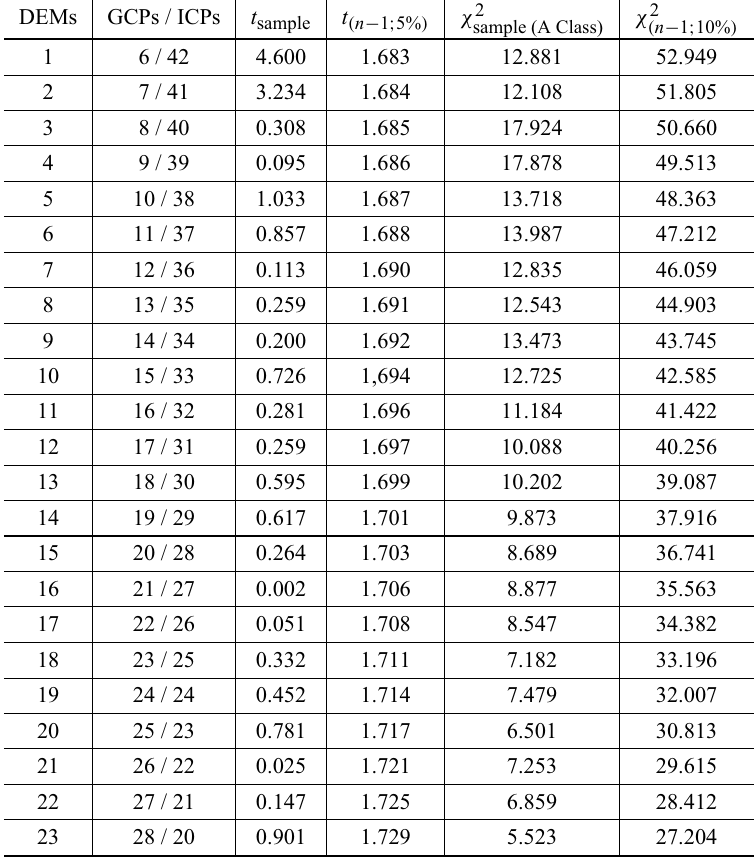
Statistics for Trend Analysis and Accuracy regarding the 23 DEMs produced from distinct combination of GCPs and